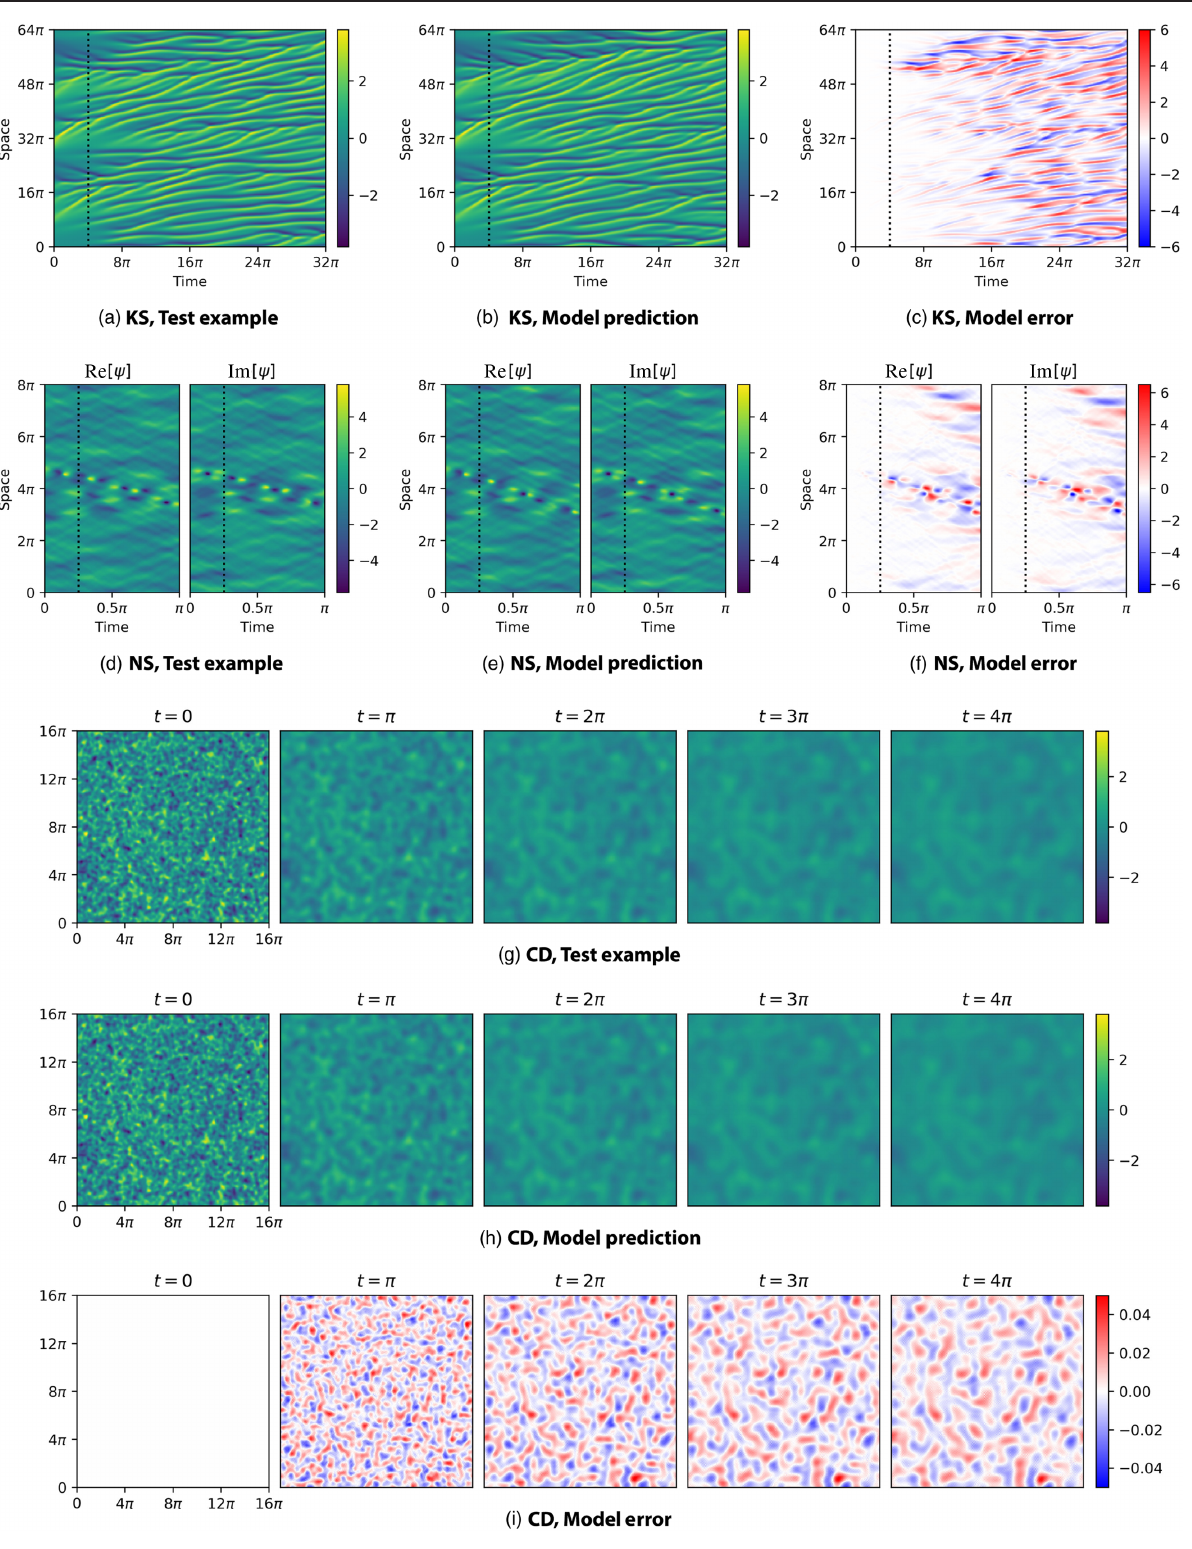
FIG. 5. Time evolution of (a),(d),(g) examples from the 1D Kuramoto-Sivashinsky, 1D nonlinear Schrödinger, and 2D convection- diffusion test sets with periodic boundary conditions, (b),(e),(h) the predicted propagation of the refined model given the initial condition at time t ¼ 0 , and (c),(f),(i) the model prediction error. The black vertical dotted line denotes the maximum amount of time propagated by the model during training, corresponding to the length of the target series. For the CD dataset, the maximum amount of time propagated by model during training is t ¼ π